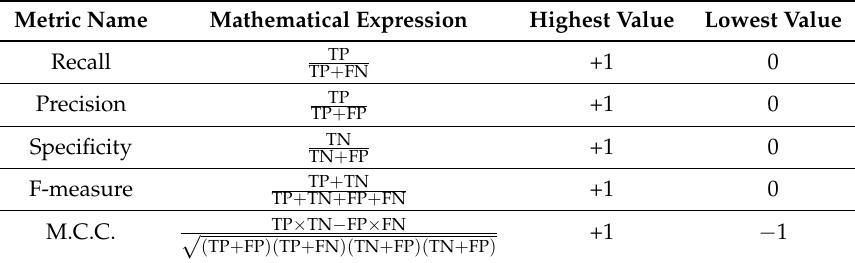
Table 2. A summary of classification performance measurement parameters.